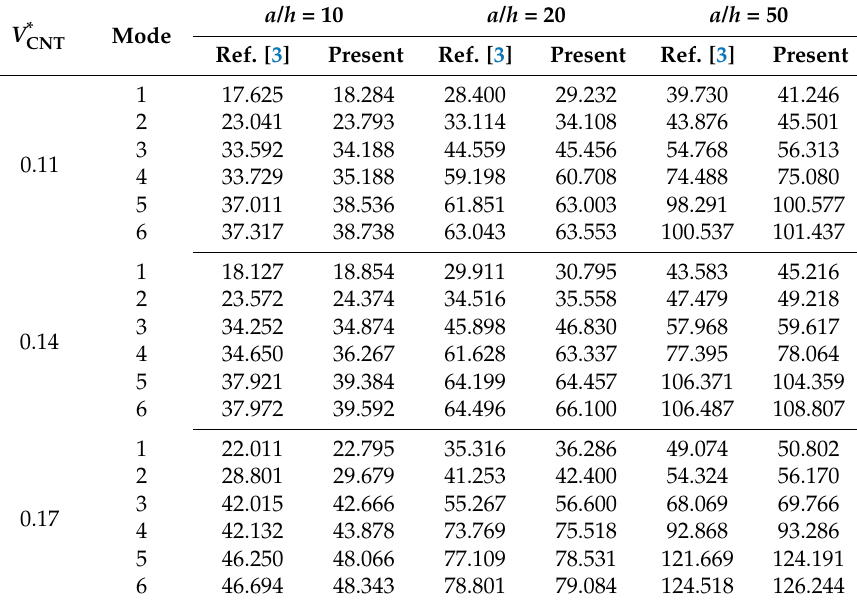
Table 4. Dimensionless first six natural frequencies ω for a UD CNT-reinforced square plate with a/h